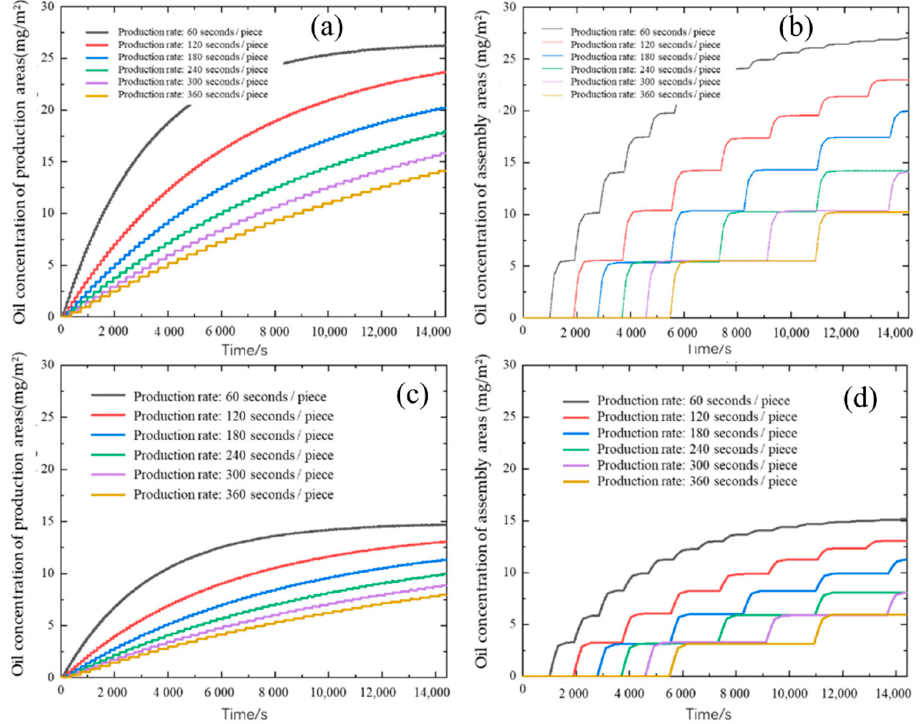
Figure 8. Influence of workpiece production rate on oil pollution concentration on the worktable in the production area and assembly table in the assembly area. ( a ) production unit 1 in the production area; ( b ) production unit 1 in the assembly area; ( c ) production unit 2 in the production area; ( d ) production unit 2 in the assembly area.